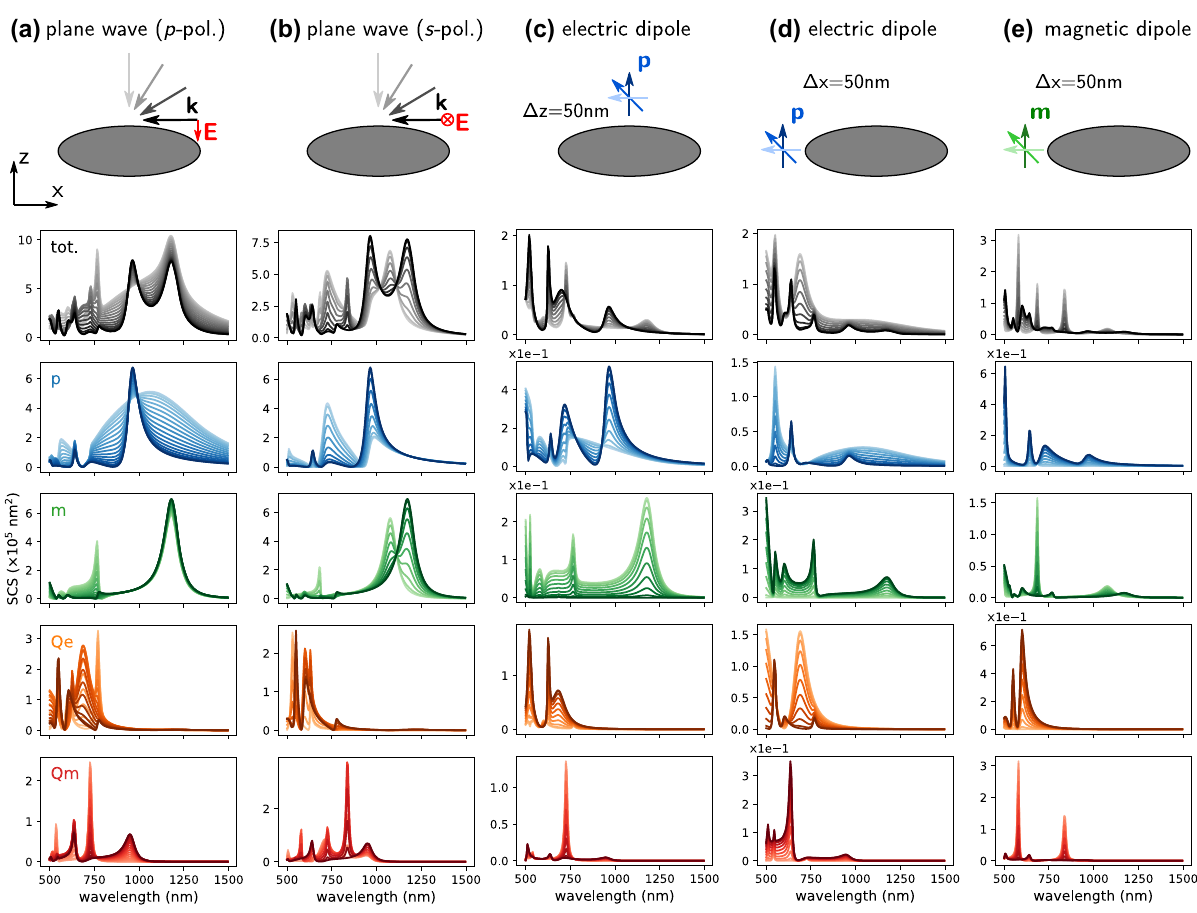
Figure 5: Scattering spectra for the same structure as in Figure 4. Via the generalized polarizabilities the modal decomposition of the scattering intensity for various different illuminations can be calculated very efficiently. We compare here the multipole expansion for various illuminations. (a) p -polarized plane wave with incident directions varying from x (dark shades) to z (light shades). (b) Same as (a) but for s polarization. (c) Illumination by a local electric dipole emitter, Δ z = 50 nm above the spheroid top surface center. Light to dark shades indicate the transition of the dipole orientation from x to z . (d) Same as (c) but the dipole is placed by Δ x = 50 nm at the left outside the spheroid. (e) Same as (e) but with a magnetic dipole transition as local light source. Plane wave illumination spectra show the scattering cross section. Dipole illumination spectra show the scattered intensity in arbitrary